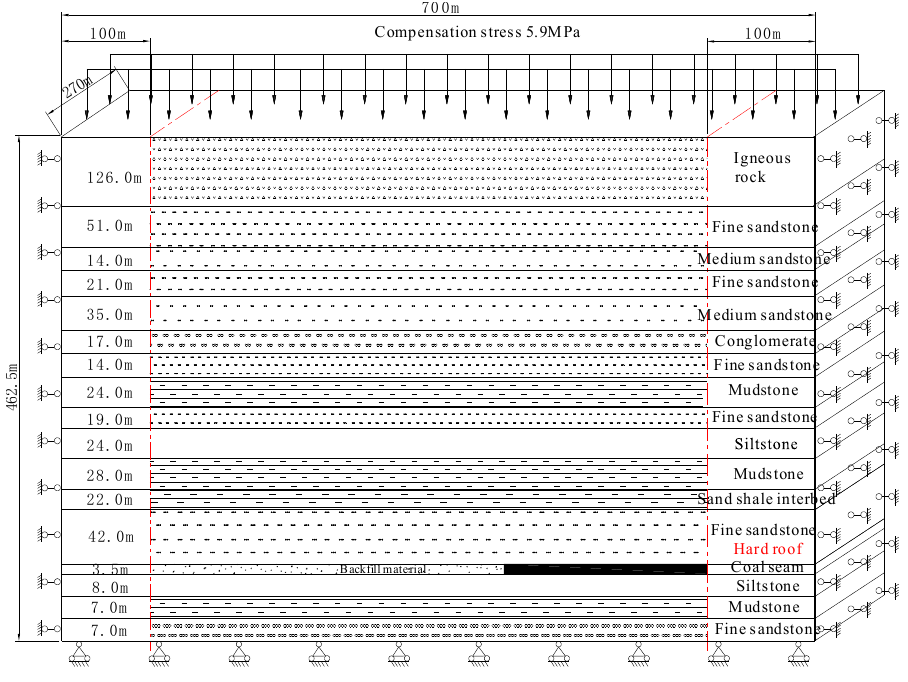
Figure 4. The numerical analysis model and basic parameters.